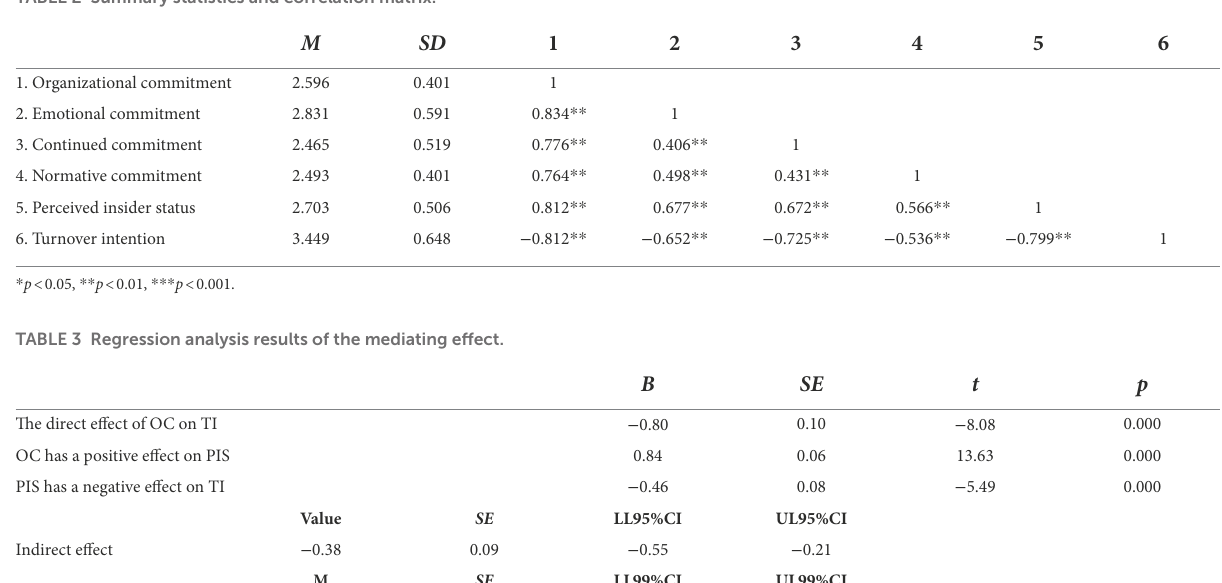
TABLE 2 Summary statistics and correlation matrix.